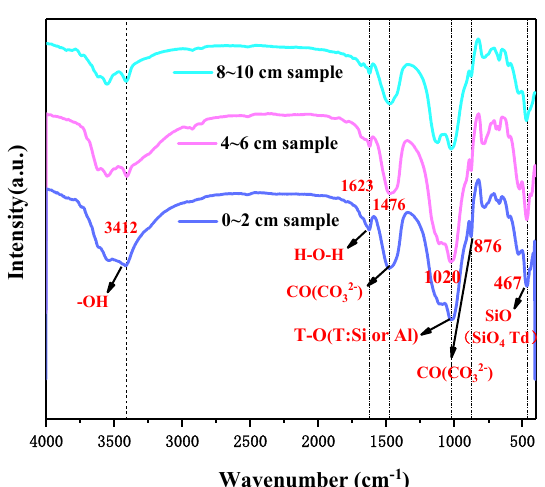
Figure 8. FT-IR spectrum of MS7 modified dredged sludge sample.